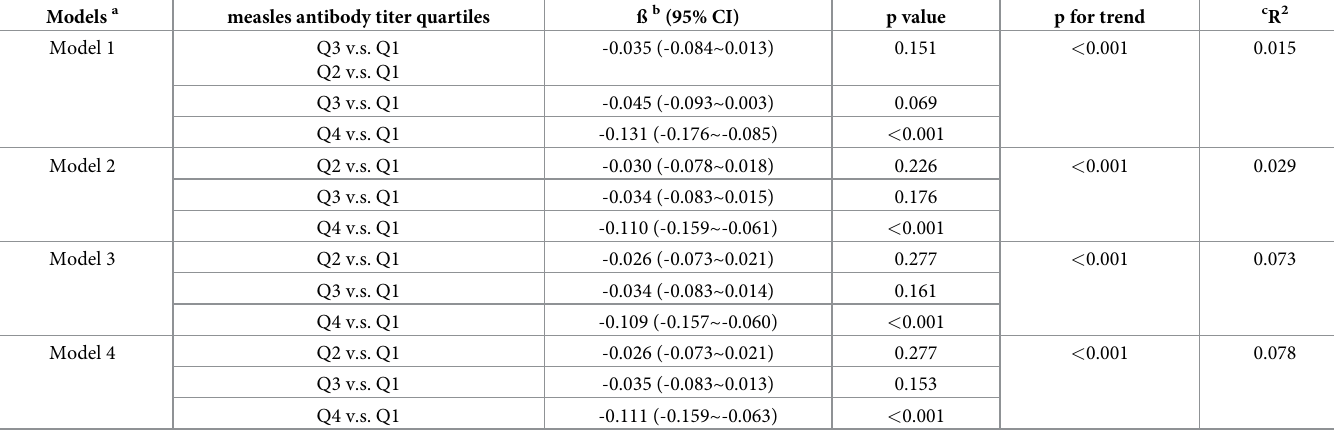
Table 3. Association between vitamin D and measles antibody titer quartiles. Models a